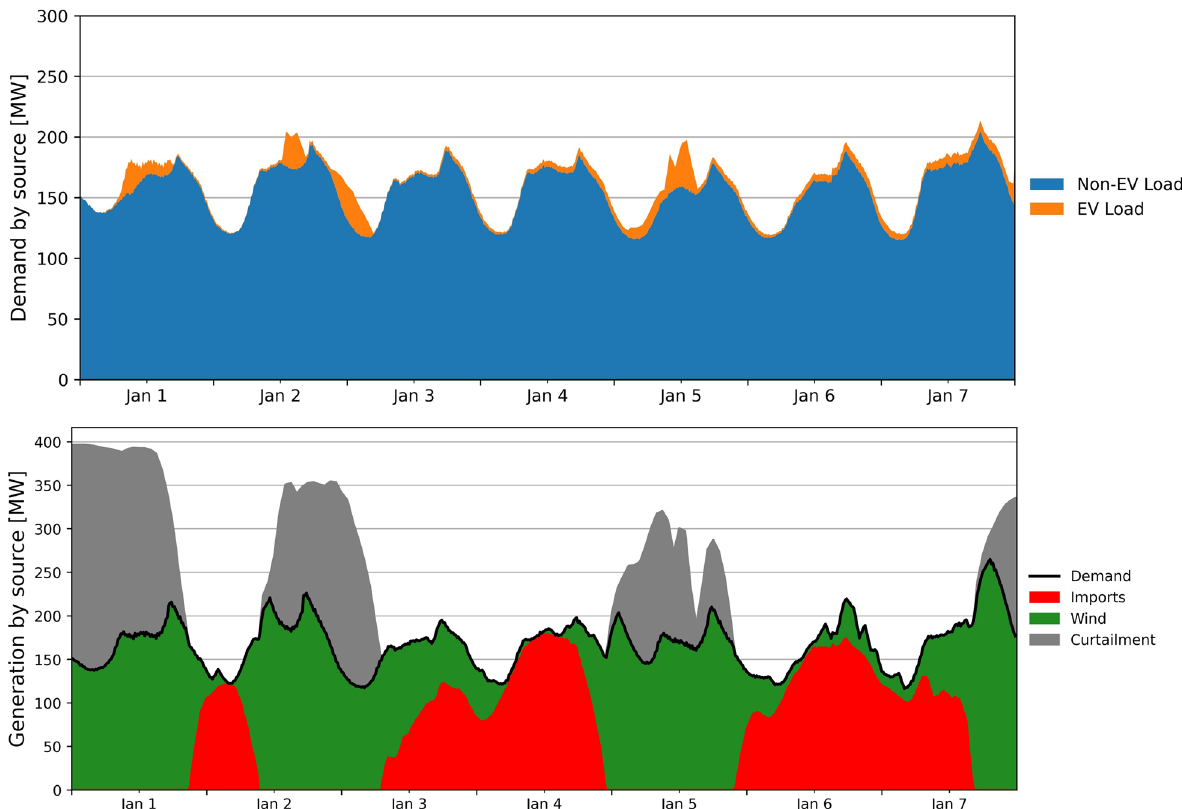
Fig. 6 Regina’s electricity demand for wind-only configuration with UCC in January, shown by a demand type (top) and b generation type (bottom)